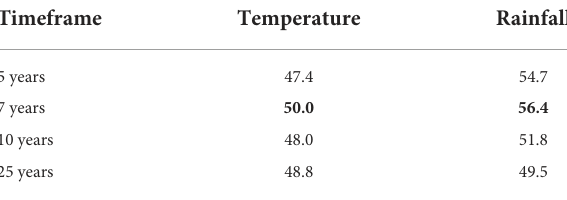
TABLE 6 Regression results of the logit model examining household and individual characteristics and the choice to adapt to temperature change ( n =